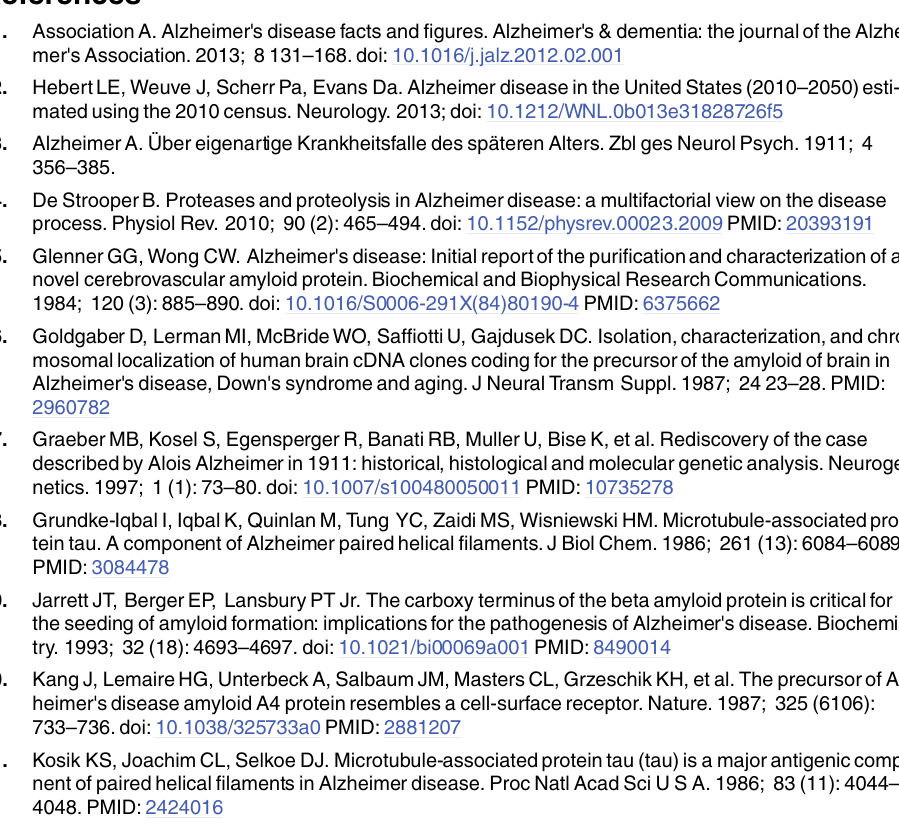
S1 Table. Cell lines used in the current